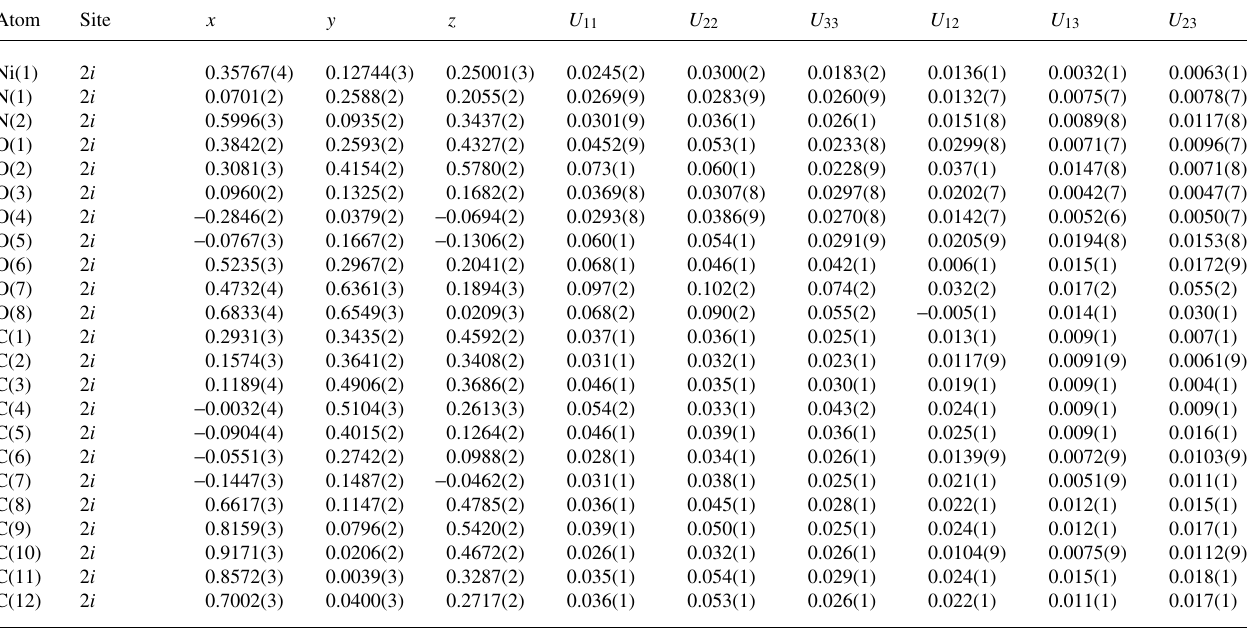
Table 3. Atomic coordinates and displacement parameters (in Å 2 ) .